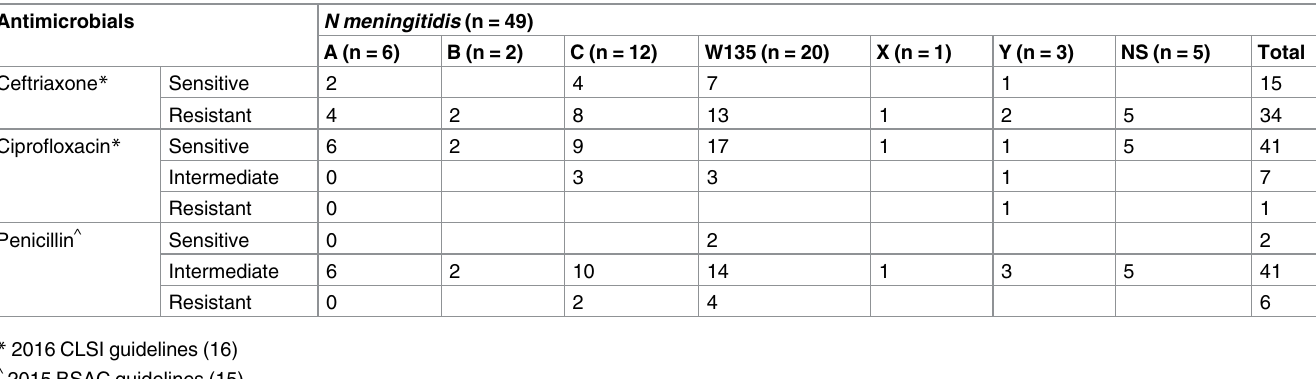
Table 4. Antimicrobial susceptibility patterns of meningococcal